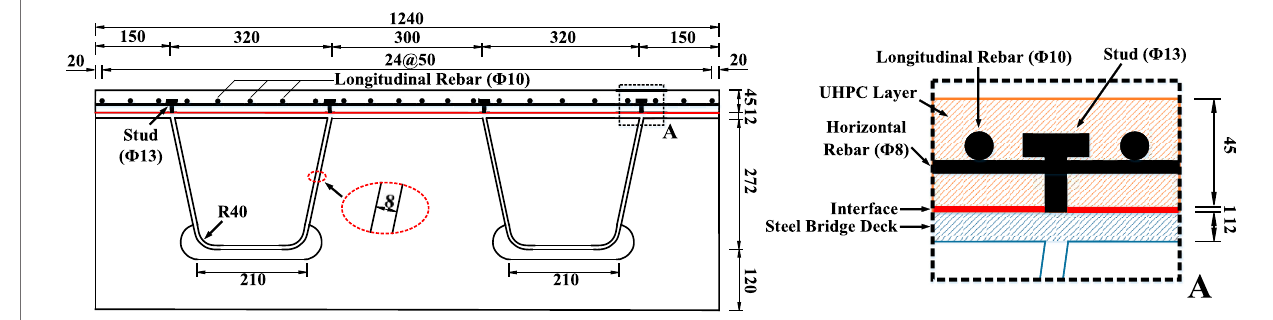
FIGURE 5 | Cross-section of the steel – UHPC composite deck (unit: mm).